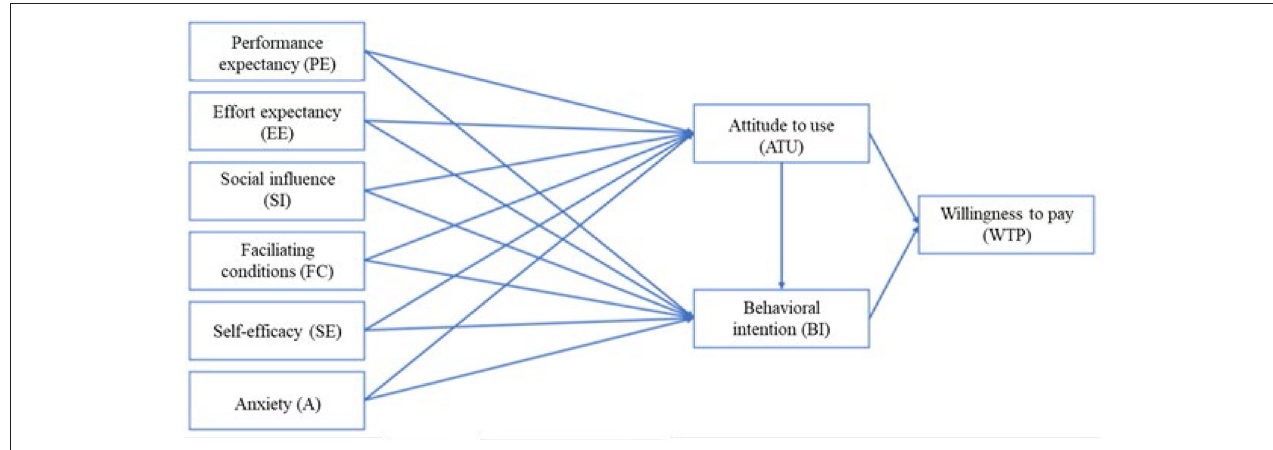
FIGURE 1 | Conceptual